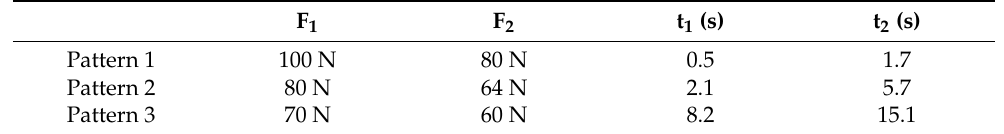
Table 2. Vertical force acting on the shoe.